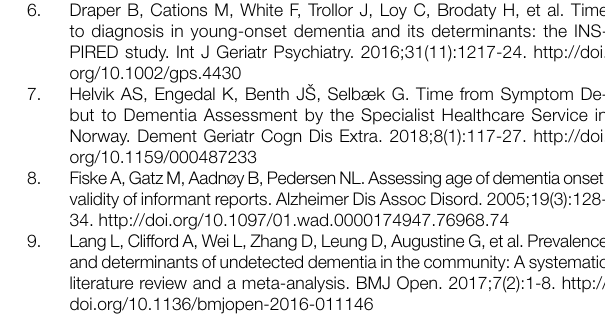
Referral delay of patients with dementia